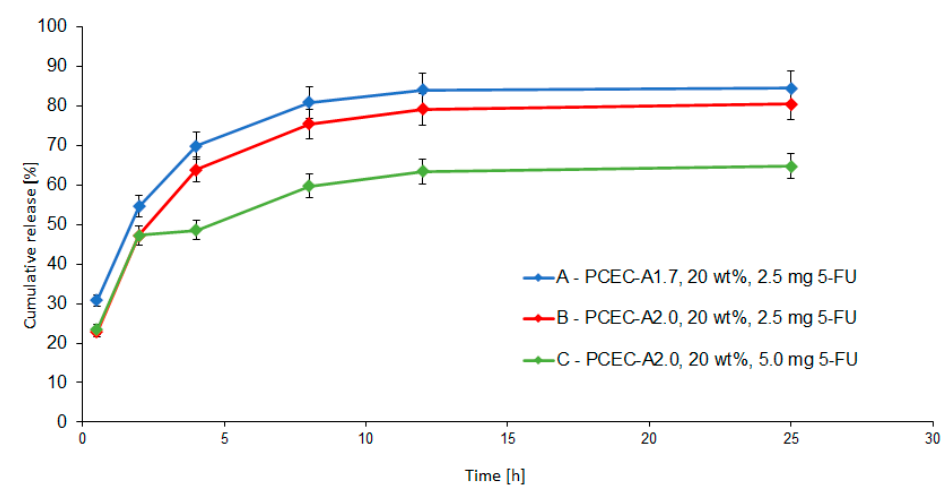
Figure 10. The 5-FU release profile from PCEC hydrogels: A (PCEC-A1.7, 25 wt%, 2.5 mg 5-FU); B (PCEC-A2.0, 20 wt%, 2.5 mg 5-FU); C (PCEC-A2.0, 20 wt%, 5.0 mg 5-FU).